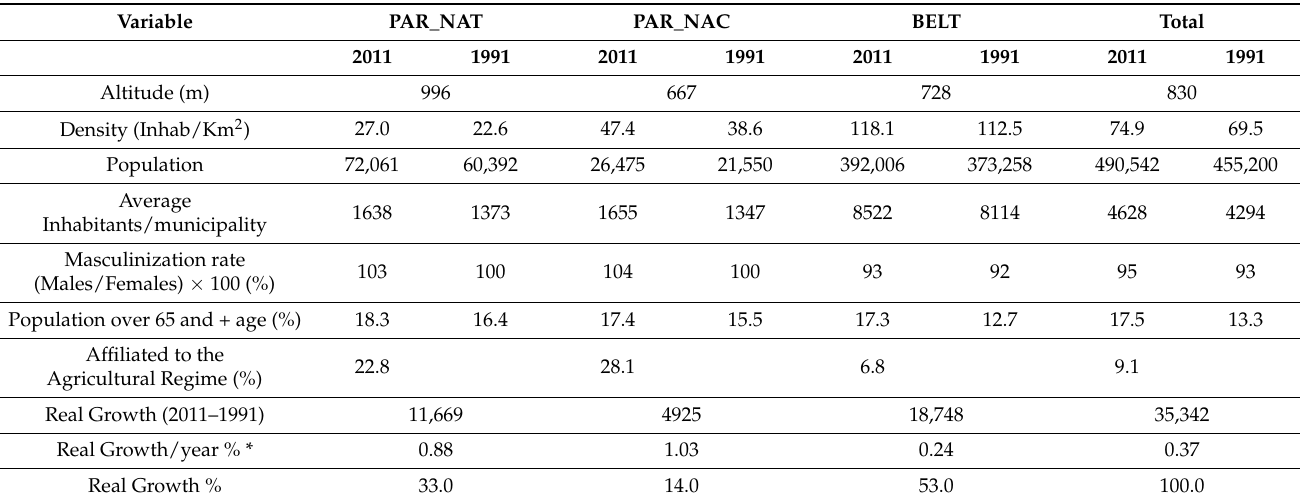
Table 1. Sierra Nevada Park: territorial framework of the